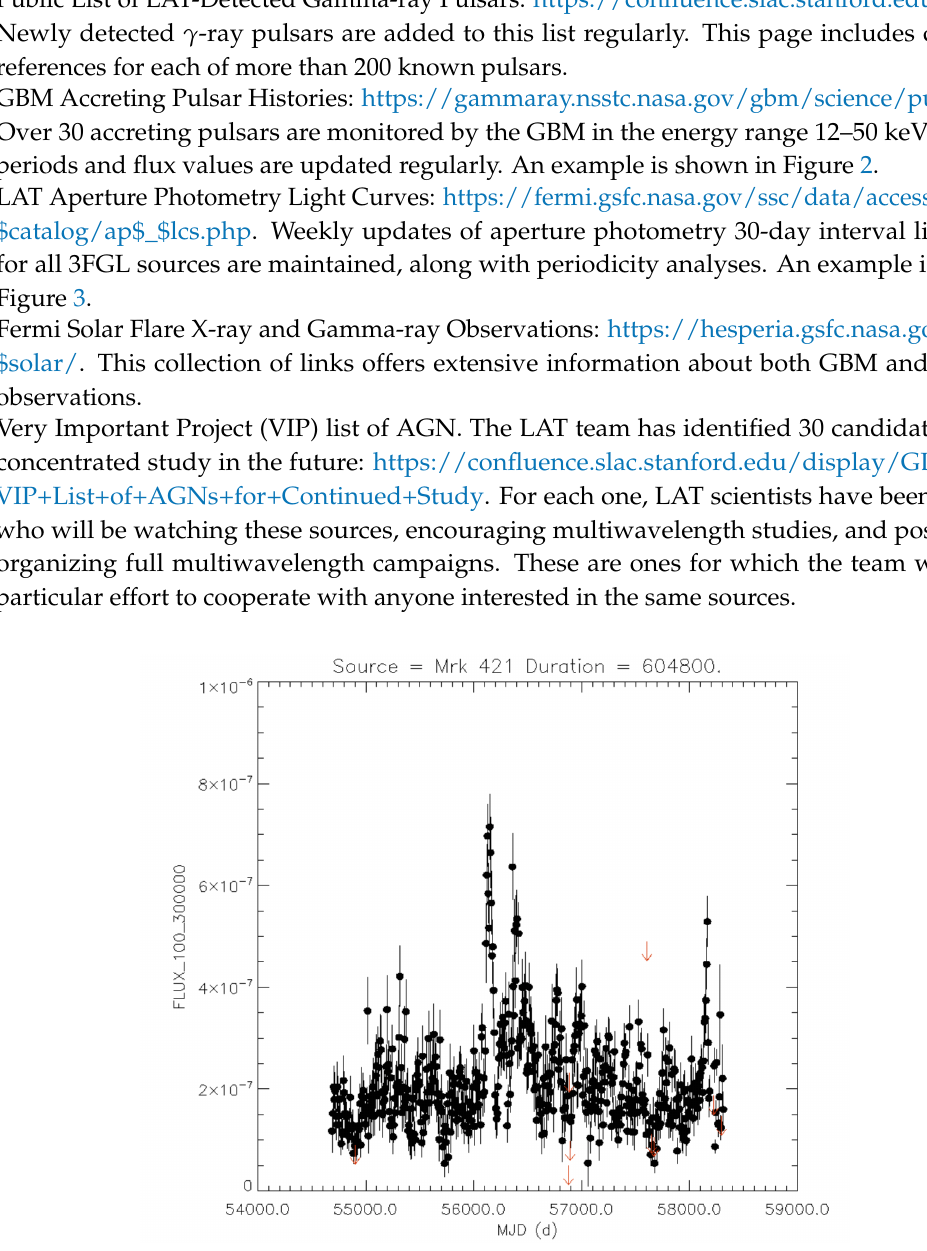
Figure 1. Weekly automated Fermi -LAT flux values (photons (100 MeV < E < 300,000 MeV) cm − 2 s − 1 ) for Mrk 421 as a function of Modified Julian Day